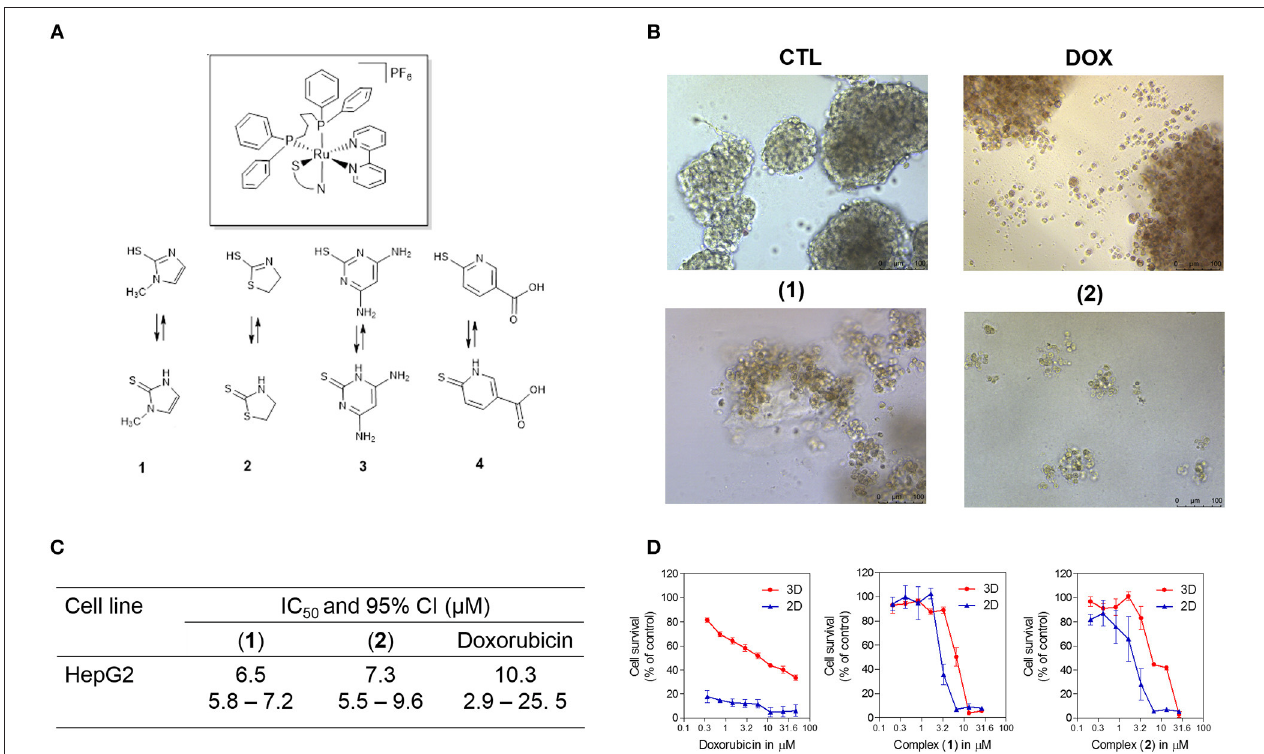
FIGURE 1 | Effect of ruthenium complexes containing heterocyclic thioamidates in a 3D in vitro model of cancer multicellular spheroids formed from HepG2 cells. (A) Chemical structure of the ruthenium complexes containing heterocyclic thioamidates. (B) Cells were examined by light microscopy (bar = 100 µ m) at the highest concentration tested after 72h of incubation. (C) IC 50 values and their respective 95% confidence intervals (95% CI) in µ M. (D) Cell survival curves of the 3D vs. 2D culture models. The curves were obtained with non-linear regression from at least three independent experiments that were performed in duplicate and were measured with an Alamar blue assay after 72h of incubation. The negative control (CTL) was treated with the vehicle (0.5% DMSO) that was used to solubilize and dilute the complexes, and doxorubicin (DOX) was used as the positive control.